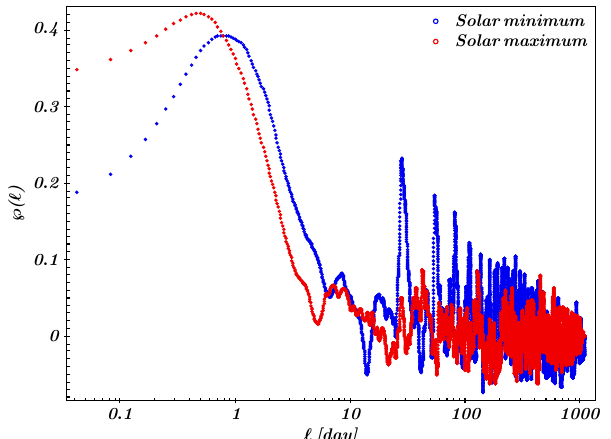
Figure 2. Cross-correlation function for total energy E and Dst index measured for the maximum activity period (red symbols) and minimum activity period (blue symbols) as a function of the lag time (cid:96)